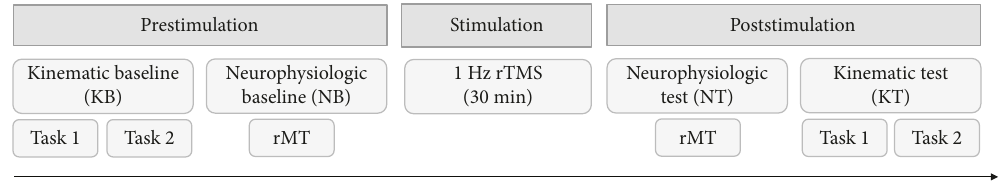
Figure 1: Daily experimental design for both MD patient and control participant. The graph represents the three daily phases of the experiment: behavioral and neurophysiological indexes were measured both before (prestimulation) and after (poststimulation) each stimulation session with low-frequency rTMS (1 Hz) on the left M1 (stimulation). The kinematic behavioral assessment (KB and KT) consisted of two tasks: fi nger abduction (task 1) and reach-to-grasp (task 2). In the neurophysiological assessment (NB and NT), the resting motor threshold was measured to assess corticospinal excitability variations. This protocol was repeated for fi ve consecutive